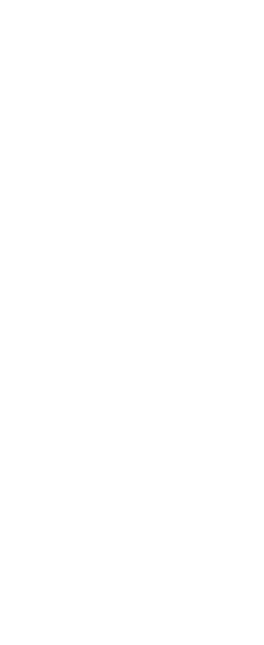
Measured Composition